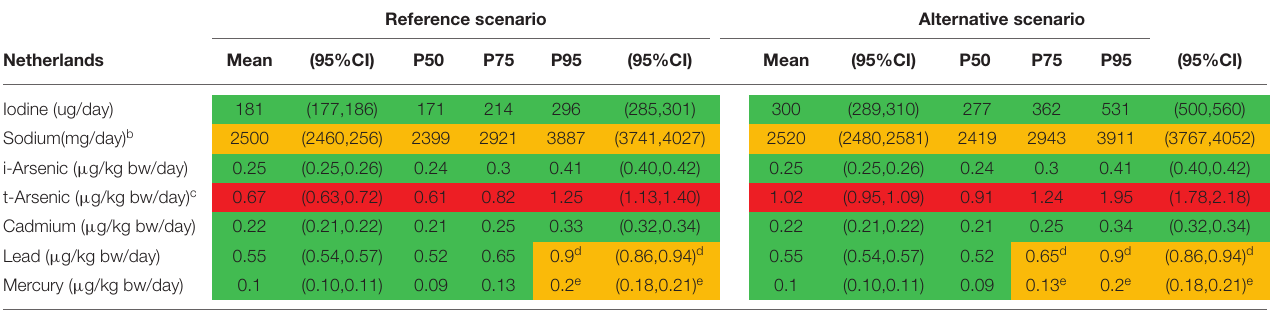
TABLE 5 | The intake of selected nutrients (iodine and sodium) and exposure to contaminants (arsenic, cadmium, lead, and mercury) in adults in the Netherlands for the reference and alternative scenario a . Reference scenario Alternative scenario